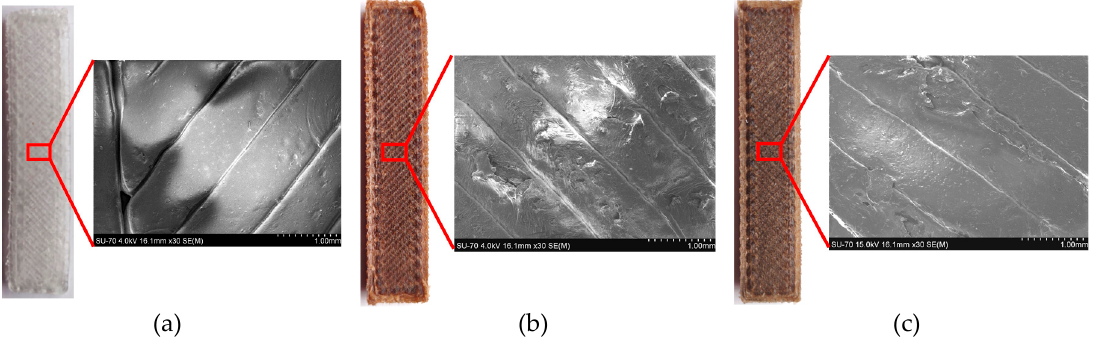
Figure 8. Photographs and SEM images of specimens: PMMA ( a ), Cork/PMMA ( b ) and C- g - PMMA/PMMA ( c ).